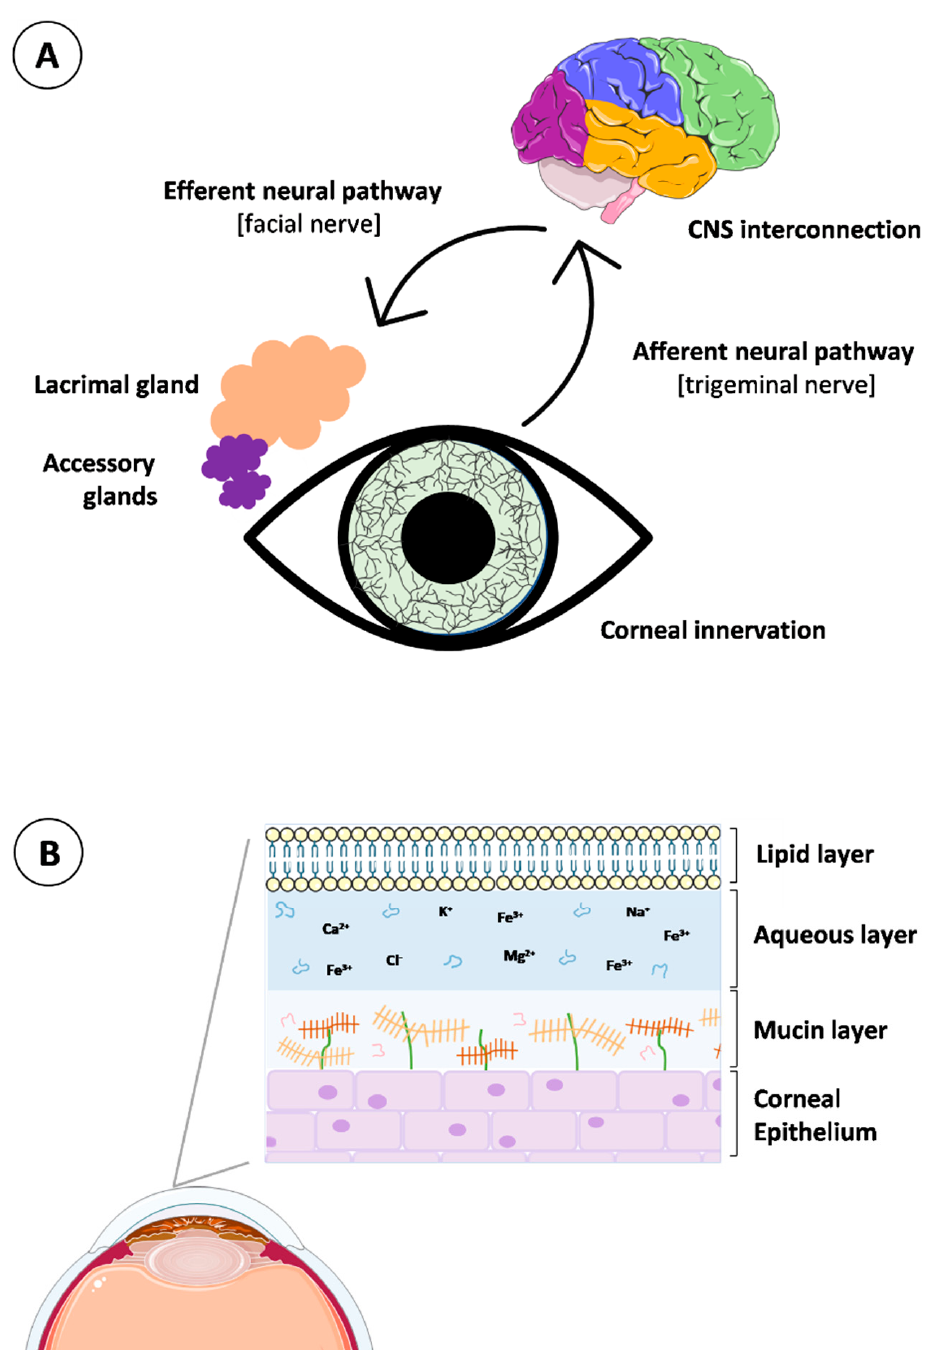
Figure 3. Lacrimal functional unit and tear fluid: ( A ) the neural complex and ( B ) the tear composition. Self-created figure using elements with Creative Common (CC)